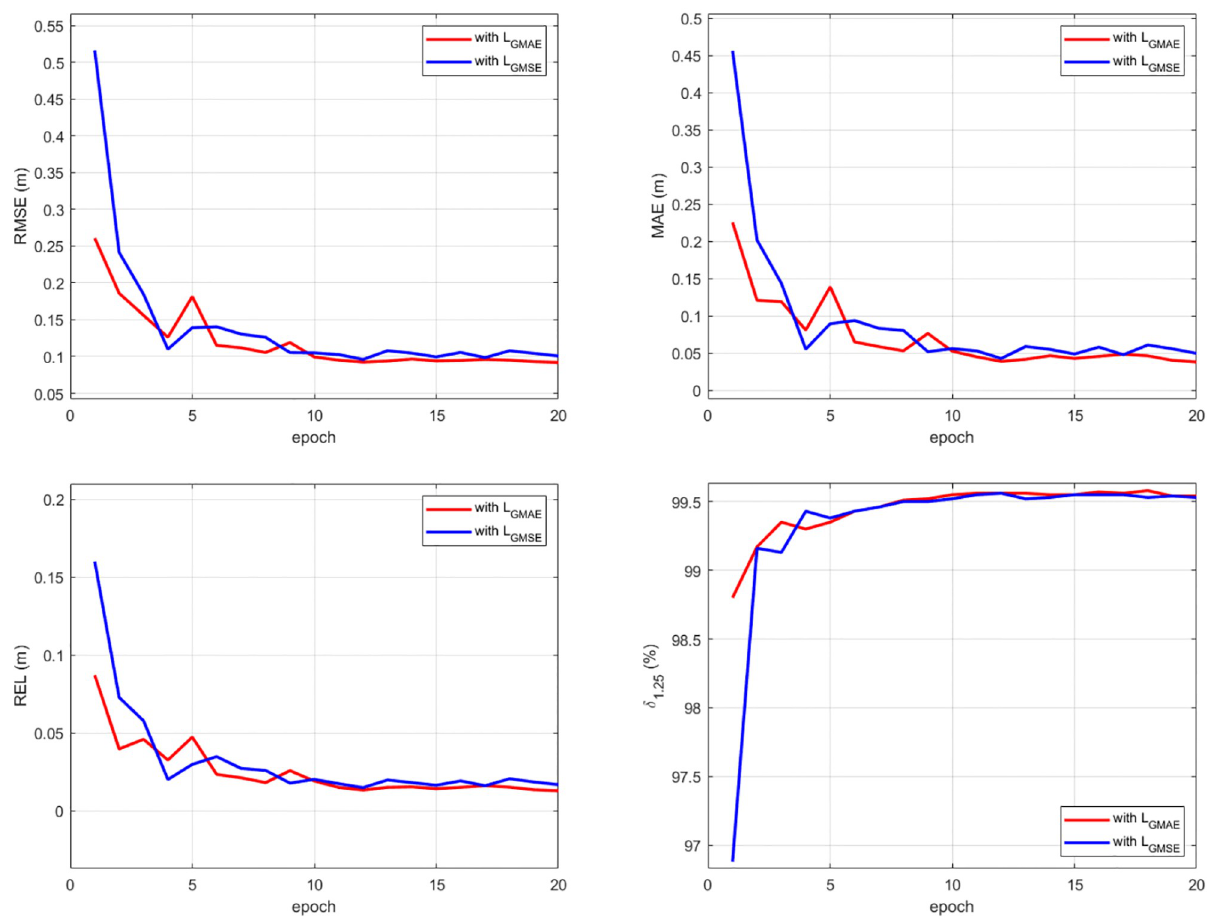
Fig 10. Convergence comparison between L